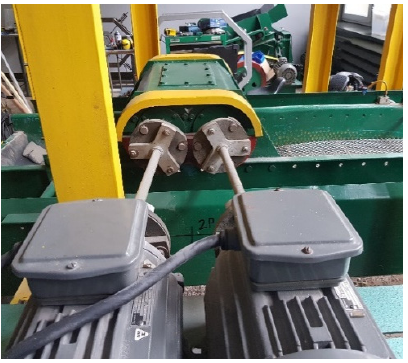
Figure 4. View of the classic drive system of a WP screen.